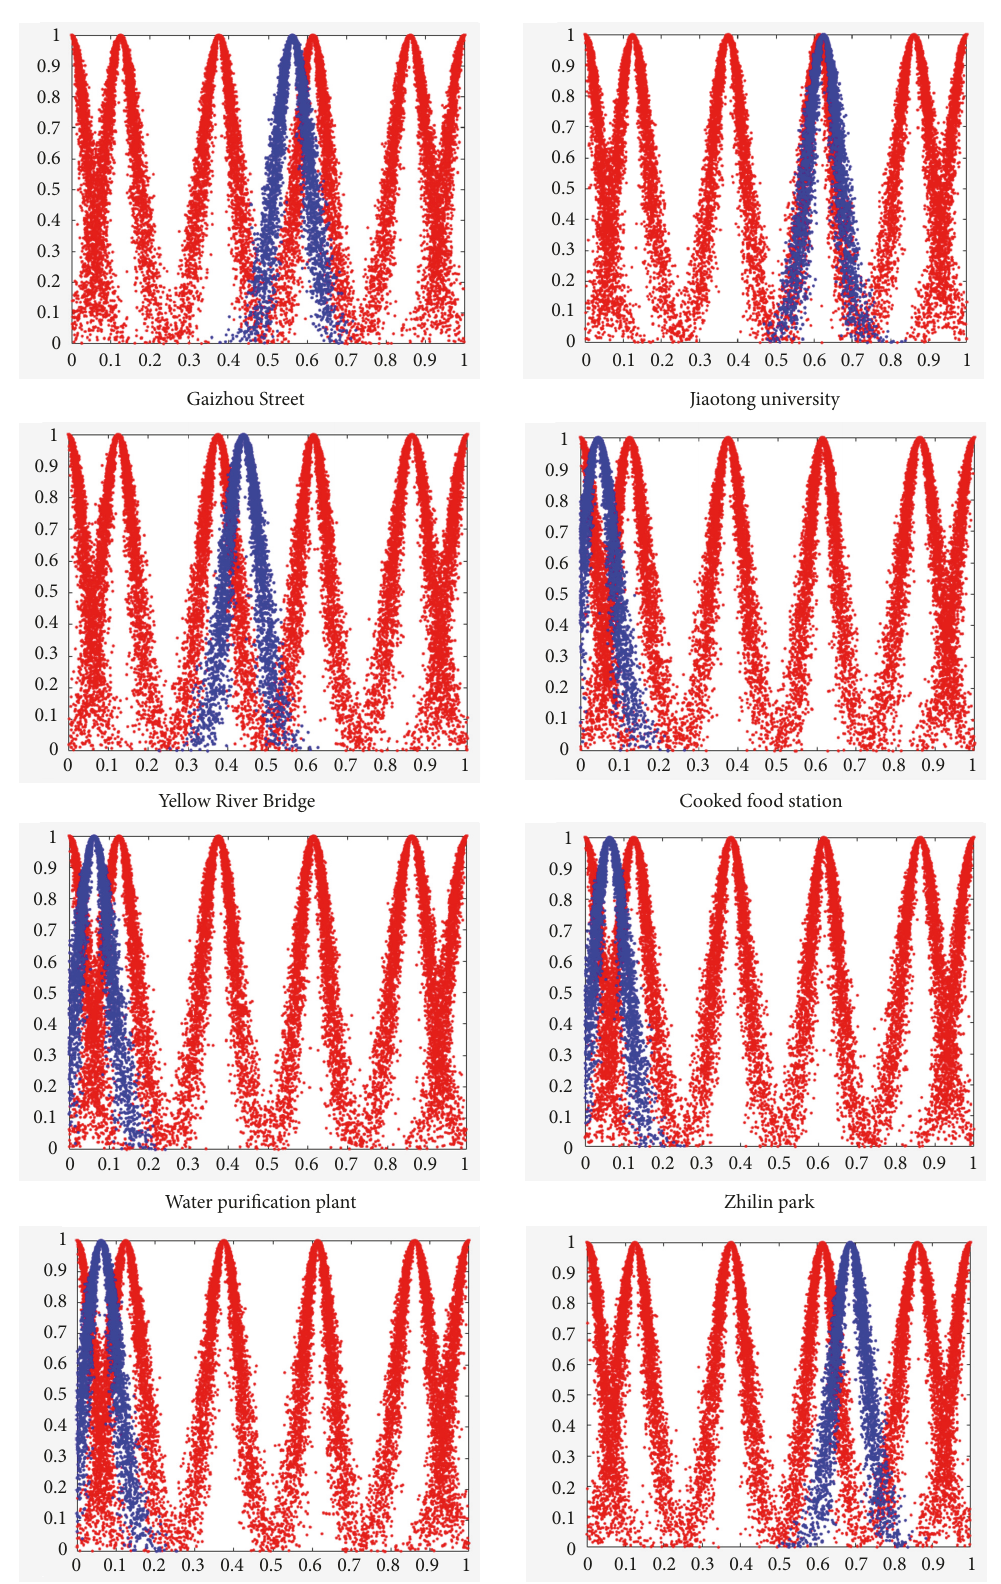
Figure 5: Identified cloud and template cloud within the